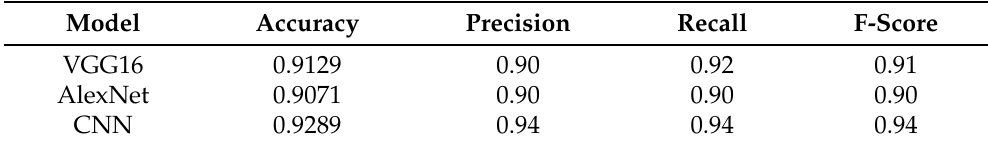
Table 7. Performance comparison of the proposed CNN deep neural network models with Transfer learning models.